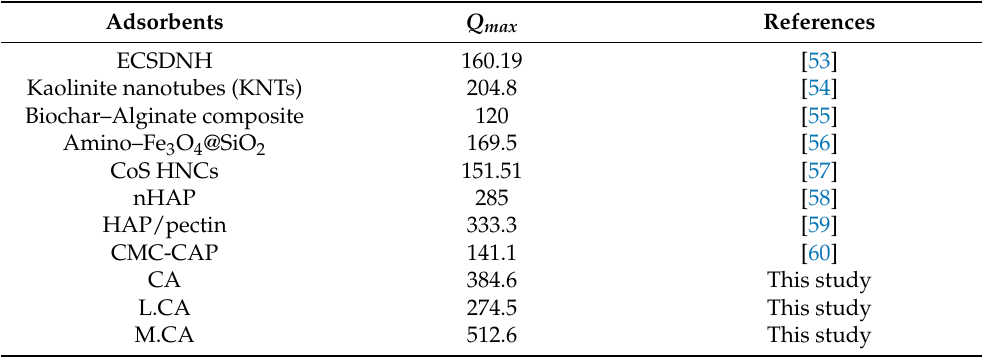
Table 4. Comparison of the studied calcite phases and other adsorbents in